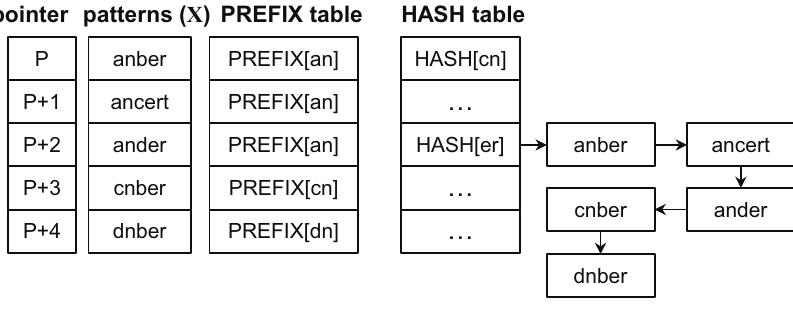
Figure 5. Sorted patterns and tables for the proposed